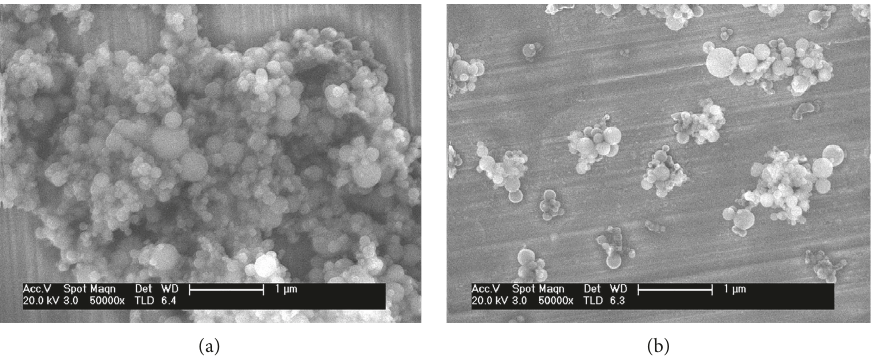
Figure 4: SEM images of SF (a) and MSF (b) particles.